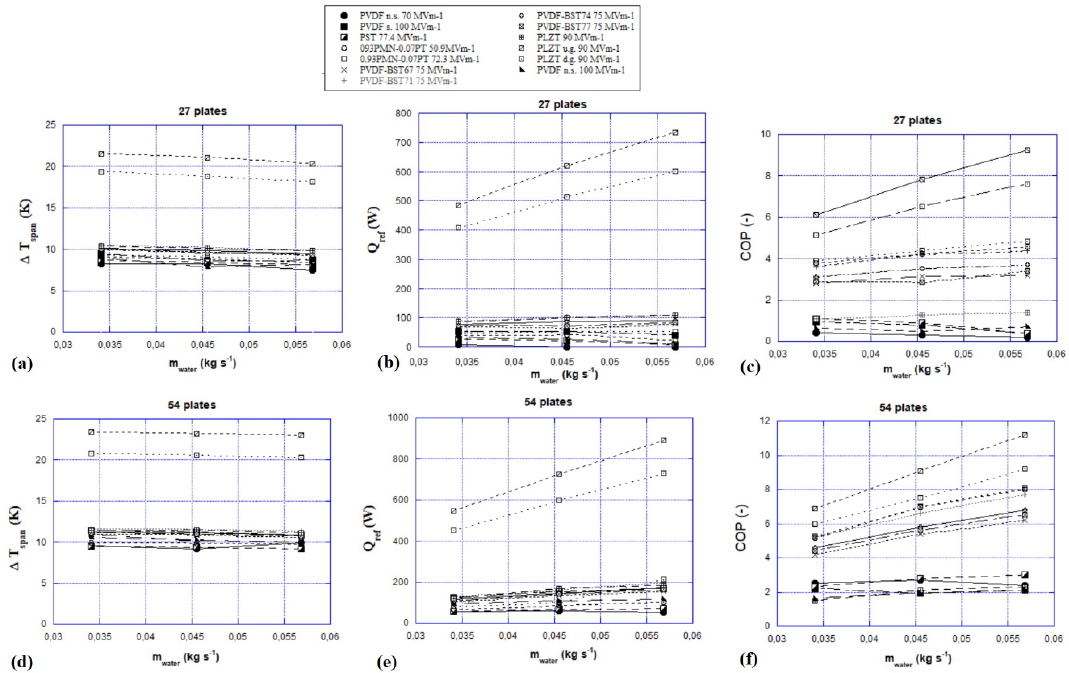
Figure 10. The energy performances of the AER, in terms of temperature span, cooling power density, and COP , carried out while the regenerator is formed by: 27 ( a , c , e ) and 54 ( b , d , f ) parallel plates (reproduced from [38], Elsevier, 2016).